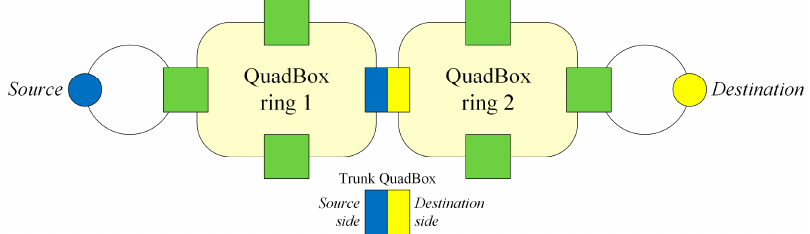
Figure 8. Source side and destination side of a trunk QuadBox.